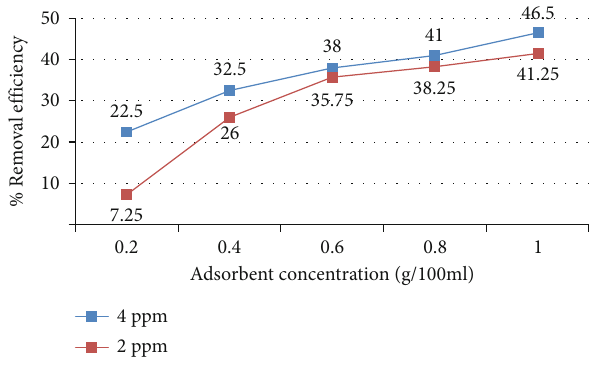
Figure 2: Neem powder adsorbent with initial fl uoride concentration 2ppm and 4ppm.